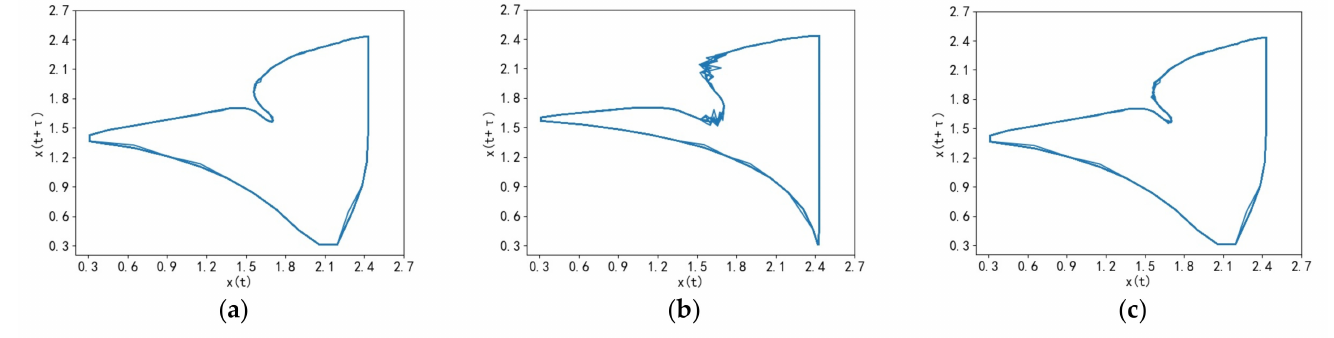
Figure 9. Phase trajectory comparison chart: ( a ) normal; ( b ) contains abnormal data; ( c ) after abnormal data